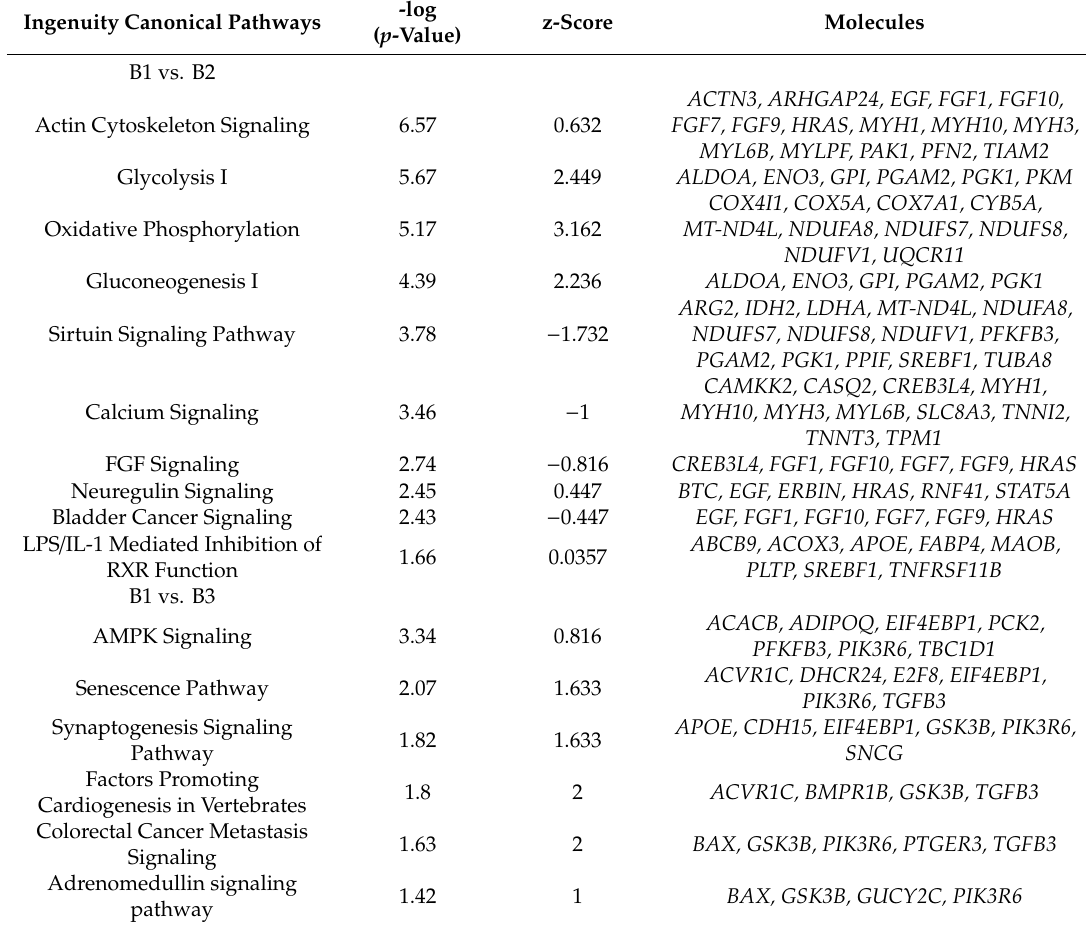
Table 3. Top 10 IPA canonical pathway in group